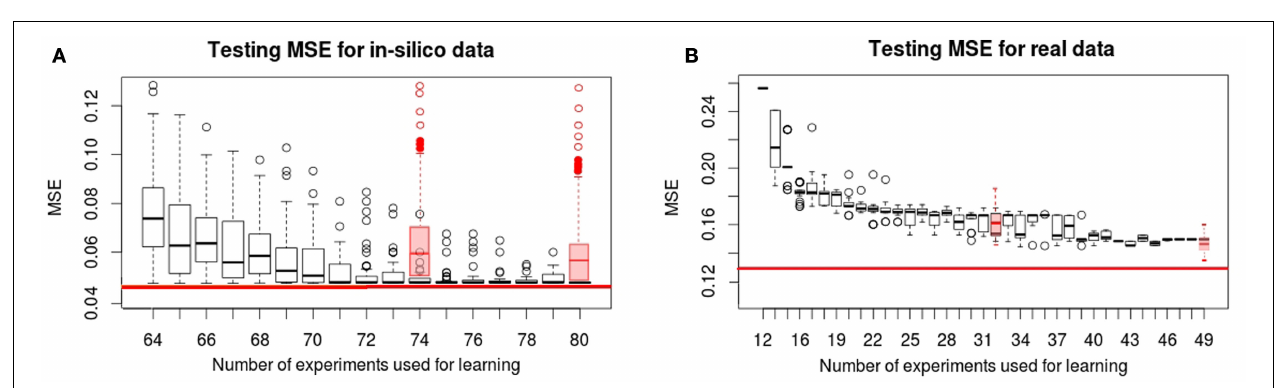
FIGURE 2 | Learning MSE for in silico (A) and real (B) phosphoproteomic datasets . The X -axis shows the number of experiments (optimal signaling perturbations and measurements associated) used for learning at each iteration.